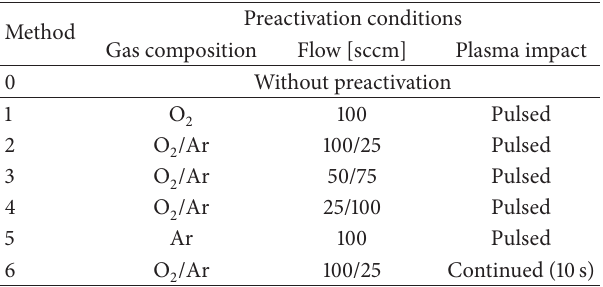
Table 1: Fiber mesh plasma preactivation process